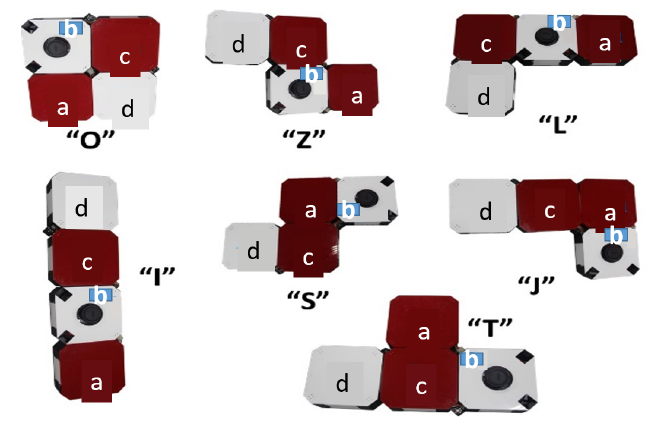
Figure 4. hTetro platform with seven